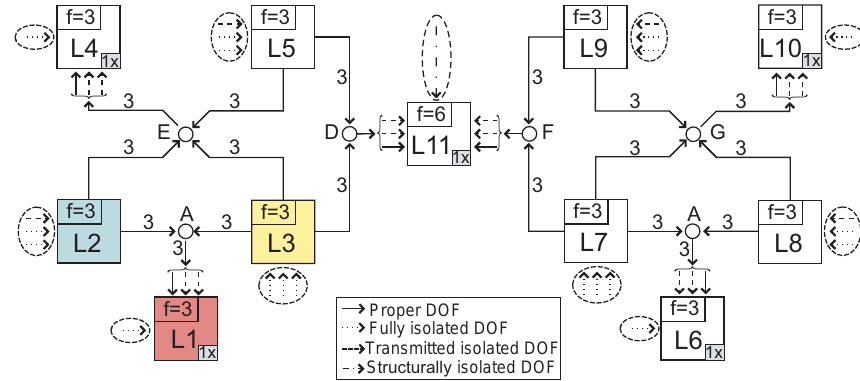
Figure 7. The directed kinematical network of the “double-banana”